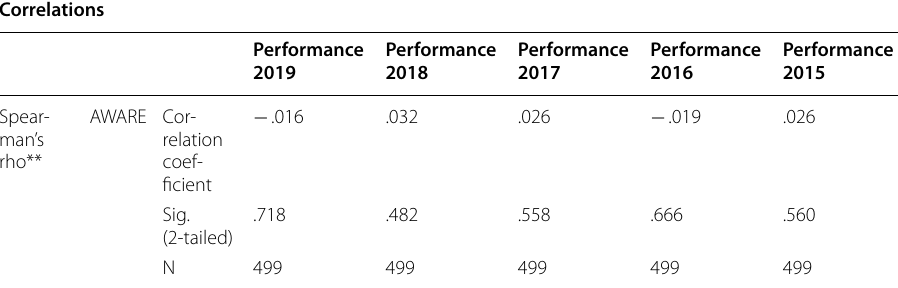
The analysis of the relationship between policy awareness and performance of SMEs indicate that there is no correlation between awareness of the policies and performance from 2015 to 2019 **Correlation is significant at the 0.01 level (2-tailed)